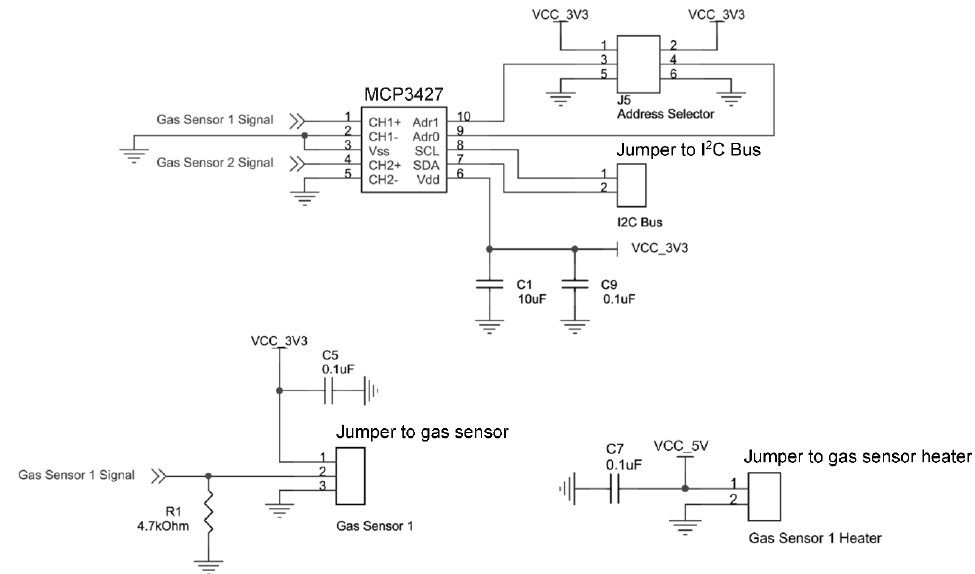
Figure 4. Gas sensor interface circuit and schematics of sensor board.